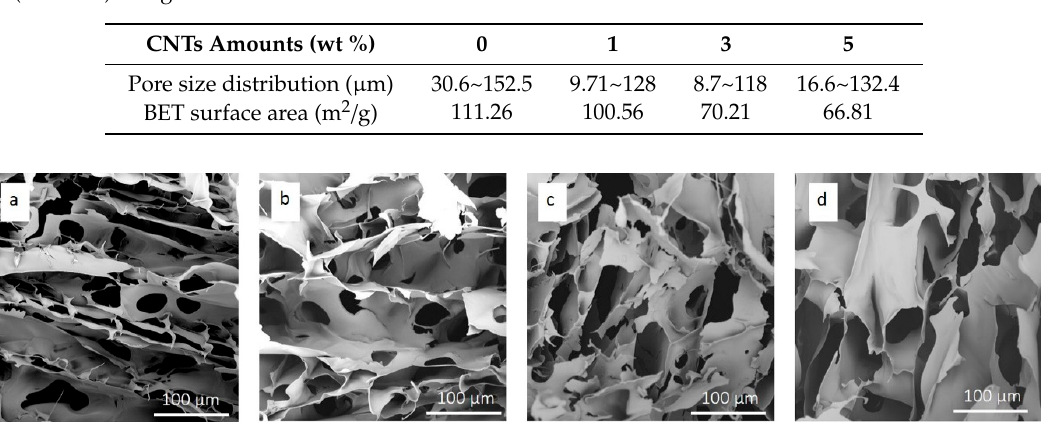
Figure 4. SEM images of CMC aerogel with different amounts of CNTs: ( a ) 0 wt %, ( b ) 1 wt %, ( c ) 3 wt %, ( d ) 5 wt %.